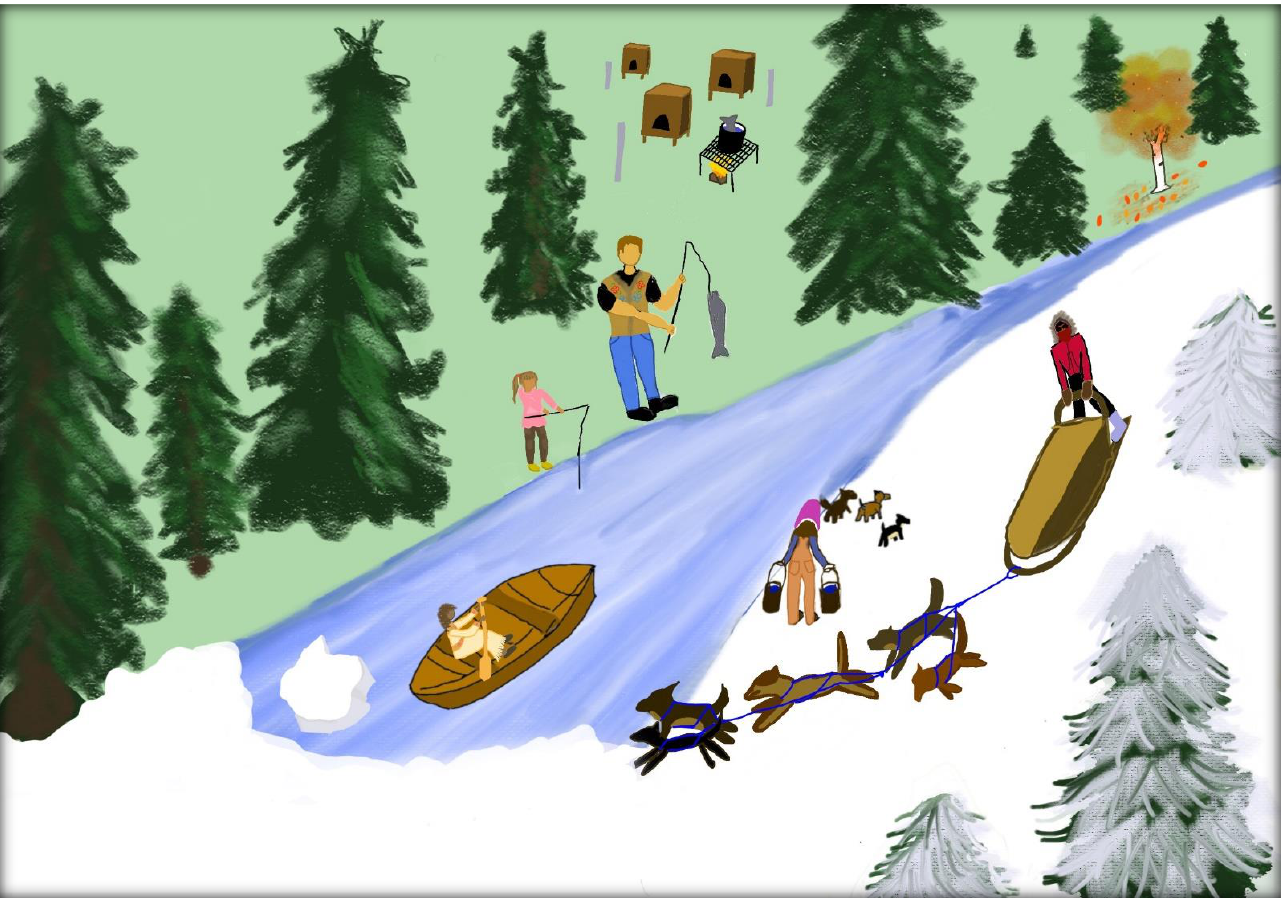
Figure 3. Relationship spheres: Connections to dogs, the environment, and people (Laura Ekada).